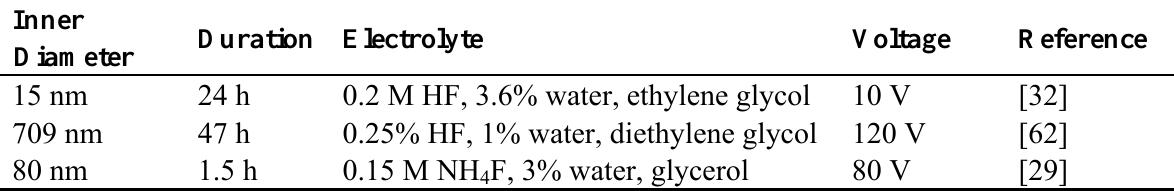
Table 3. Experimental conditions to achieve nanotubes with different inner diameters.